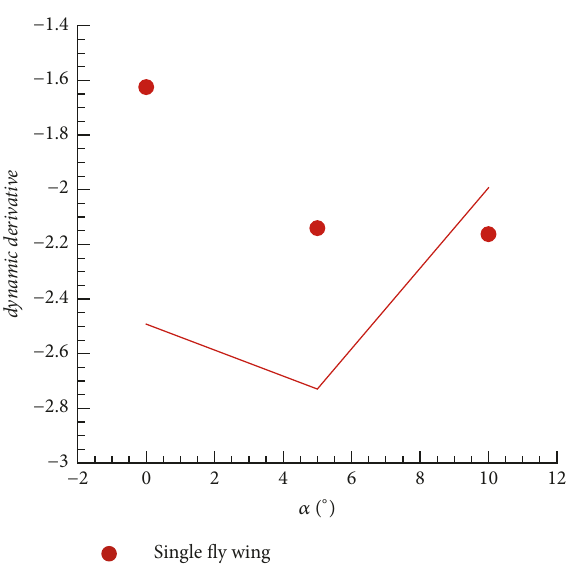
Figure 8: Steady aerodynamics-lift coefficients Cl , drag coefficients Cd , and pitching moment coefficients Cmy .